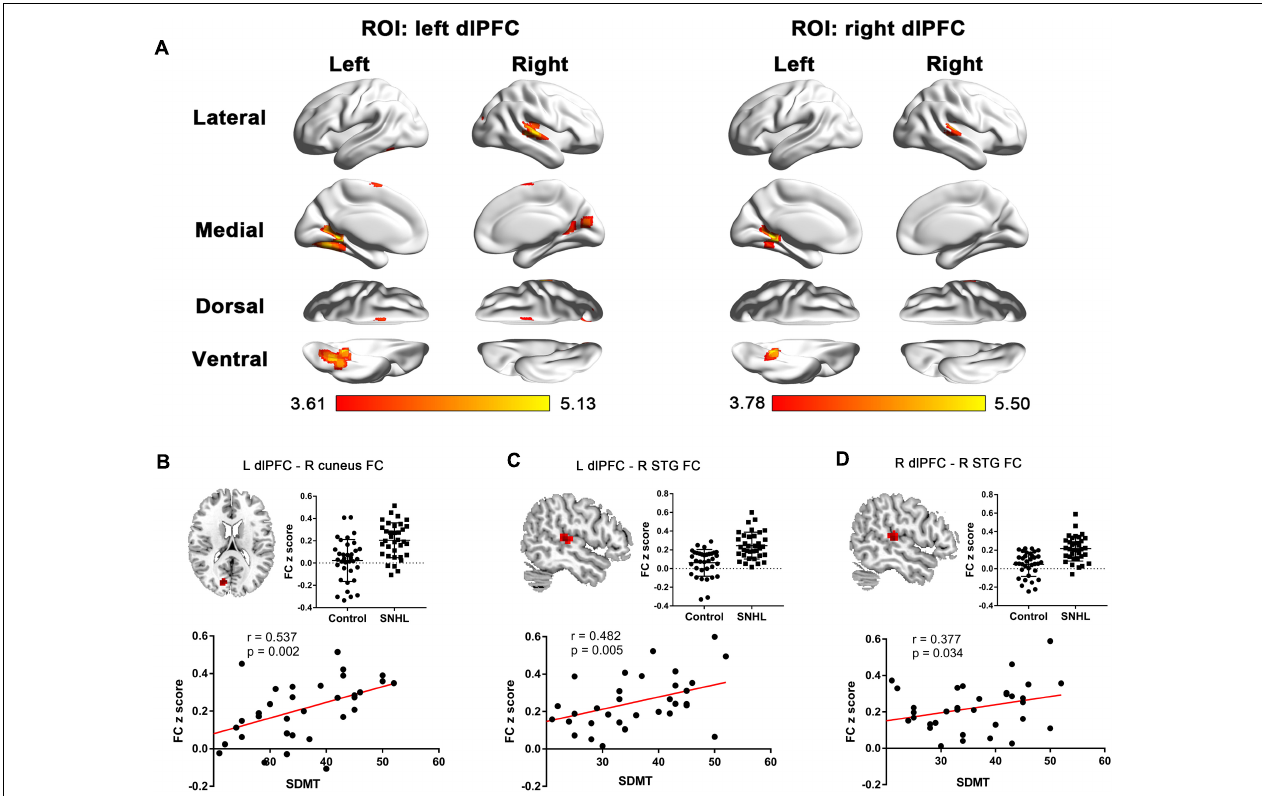
FIGURE 2 | (A) The between-group difference distribution map of FC with the seed set to the left and right dlPFC independent of age, sex, or education ( p < 0.05, corrected by FDR). Significantly increased FC is present in the red-yellow heat scales. The color bar below shows the t -scores obtained from the between-group comparisons. The SDMT scores are positively correlated with the left dlPFC-seeded FC in the right cuneus (B) , left dlPFC-seeded FC in the right STG (C) , and the right dlPFC-seeded FC in the right STG (D) in patients with SNHL, after controlling for age, sex, and education. FC, functional connectivity; dlPFC, dorsolateral prefrontal cortex; FDR, false discovery rate; SDMT, Symbol Digit Modalities Test; STG, superior temporal gyrus; ROI, region of interest; L, left; R, right.